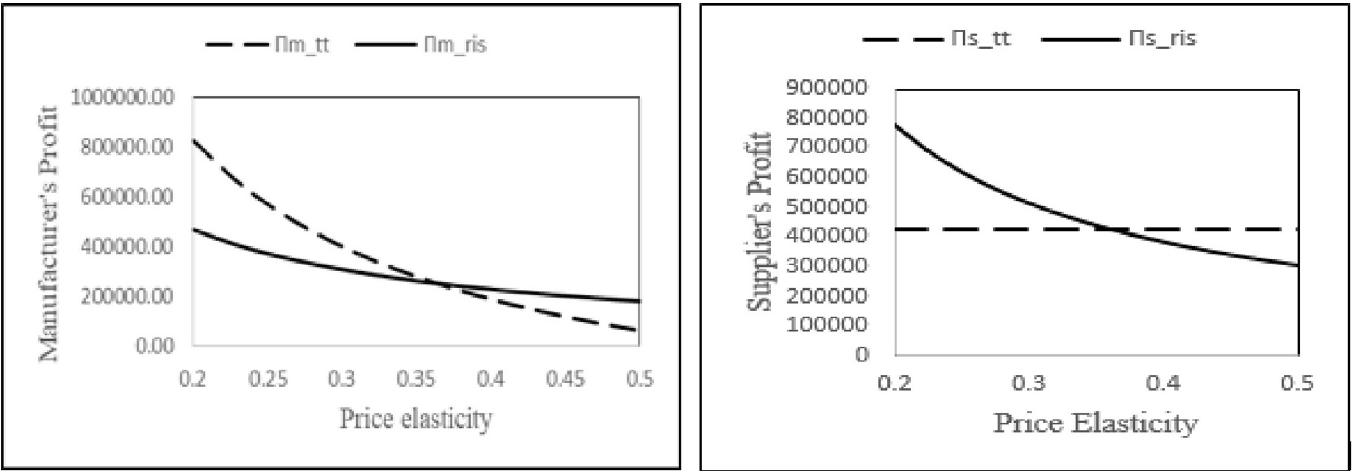
Fig 2. Comparison of manufacturer’s and supplier’s profit in two contracts w.r.t. the price elasticity( β ).